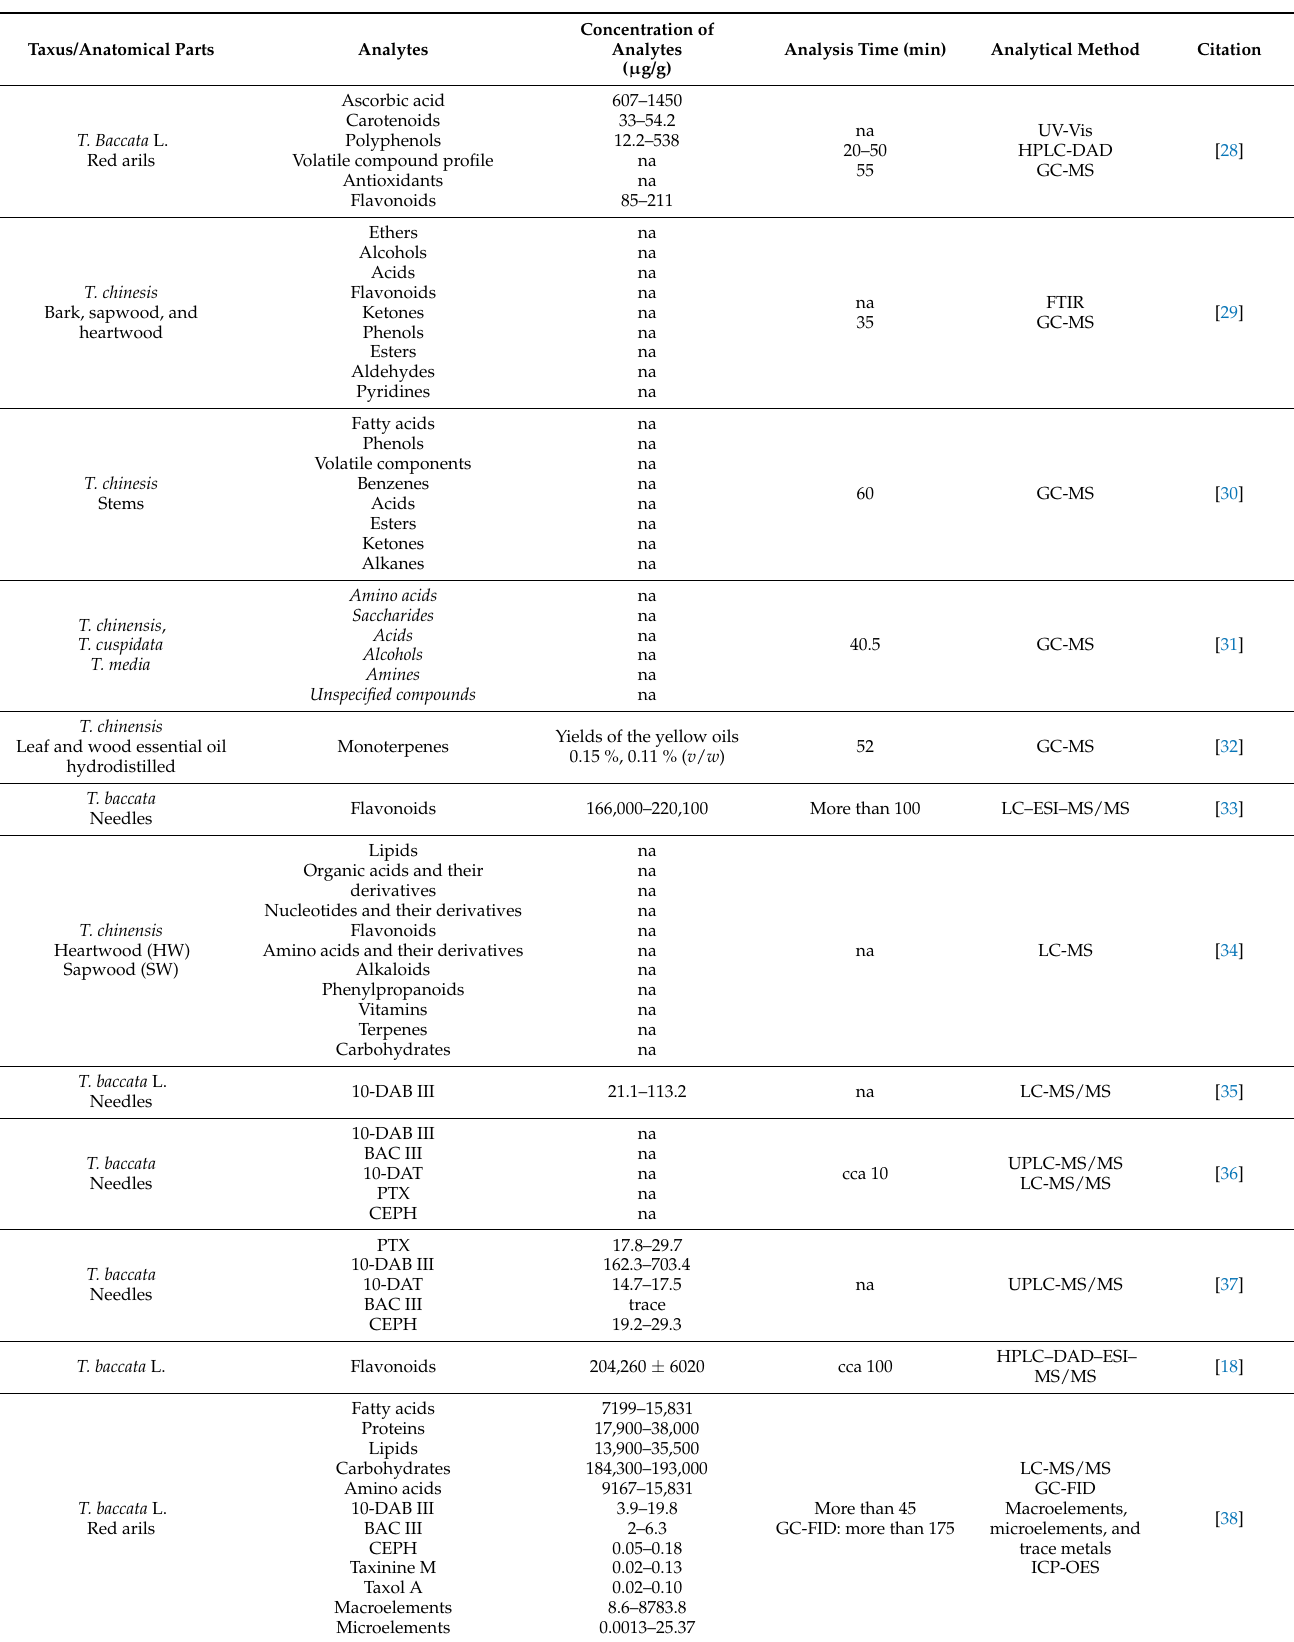
Table 1. Overview of the latest methods for analysing the composition of Taxaceae spp. for the last 5 years. The table does not include publications focused on in vitro, in vivo, clinical or forensic